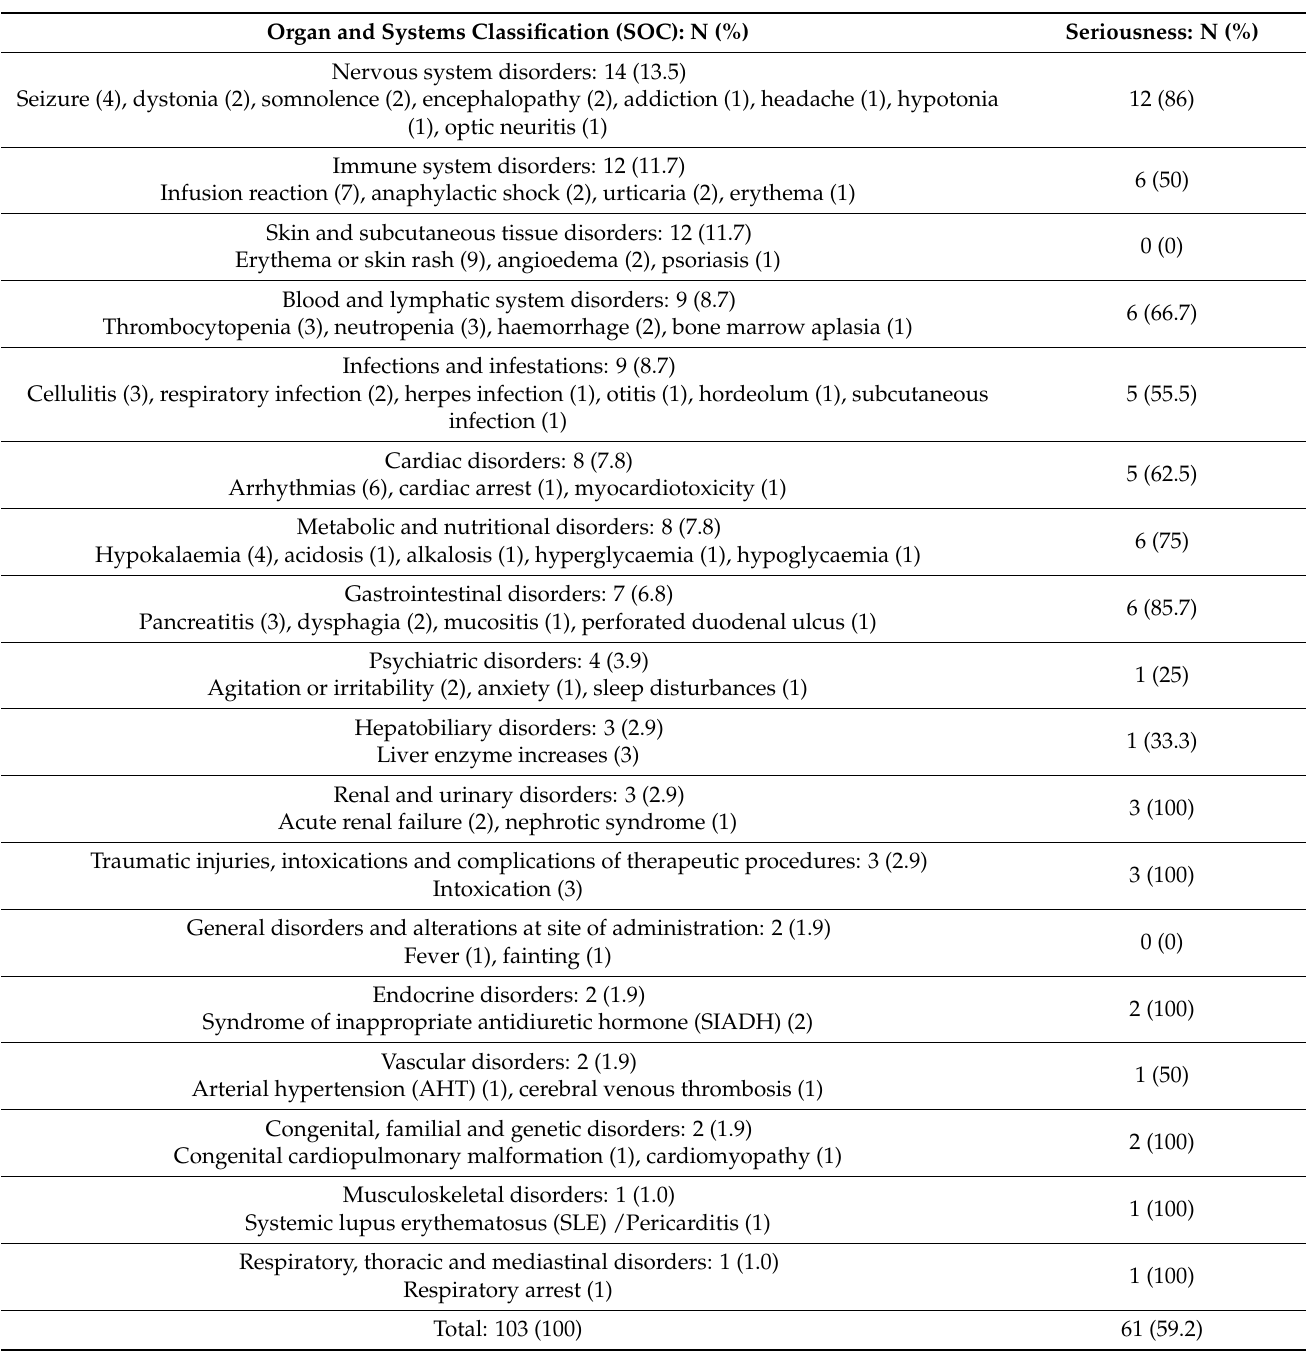
Table 1. Classification of Adverse Drug Reactions according to Organ and System Classification and seriousness. Organ and Systems Classification (SOC): N